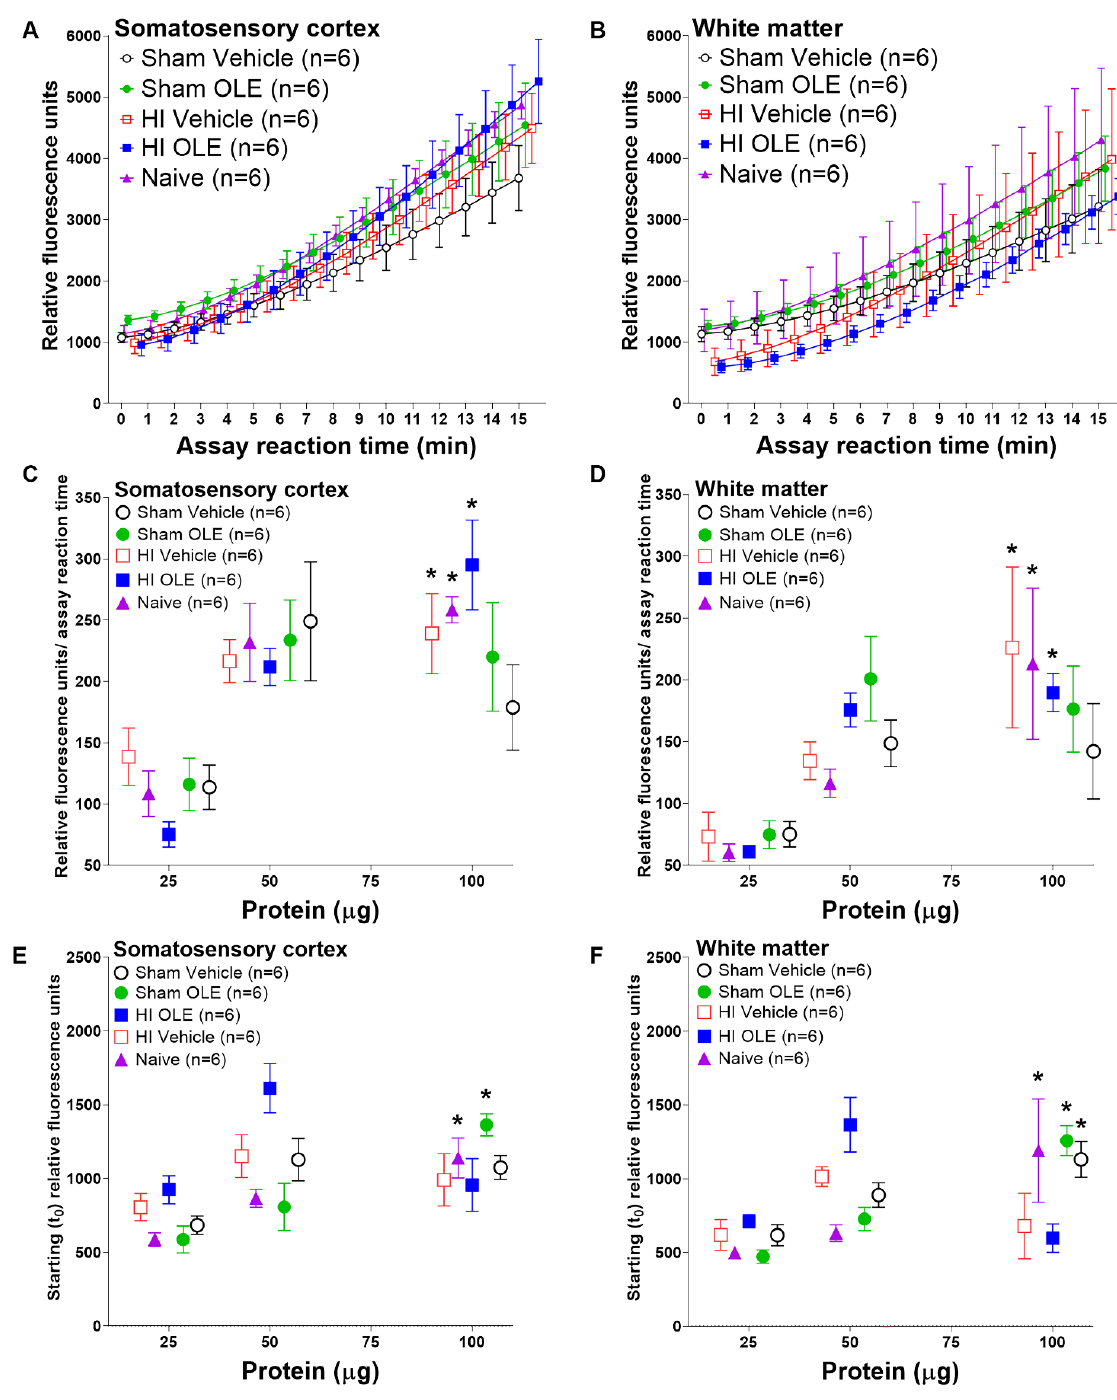
Figure 5. Proteasome activity in piglets randomized to hypoxia-ischemia (HI) or sham procedure, and oleuropein (OLE) or vehicle. All groups except for the naïve unanesthetized control group received hypothermia. ( A , B ) Example assay reaction data in somatosensory cortex and white matter with 100 µg protein in the fluorescence proteasome activity assay. ( C , D ) The slope of proteasome activity over assay reaction time increased in the cortex and white matter with greater assay protein input among HI OLE (cortex: p < 0.001; white matter: p < 0.001), HI vehicle (cortex: p = 0.023; white matter: p = 0.013), and naïve piglets (cortex: p = 0.002; white matter: p = 0.007). ( E ) In the cortex, the starting (t 0 ) proteasome activity increased with greater protein input in sham OLE ( p < 0.001) and naïve piglets ( p < 0.001). ( F ) The white matter’s t 0 proteasome activity increased with higher protein input in sham OLE ( p < 0.001), sham vehicle ( p = 0.002), and naïve groups ( p = 0.021). Data are shown as means with standard errors of the means. * p <